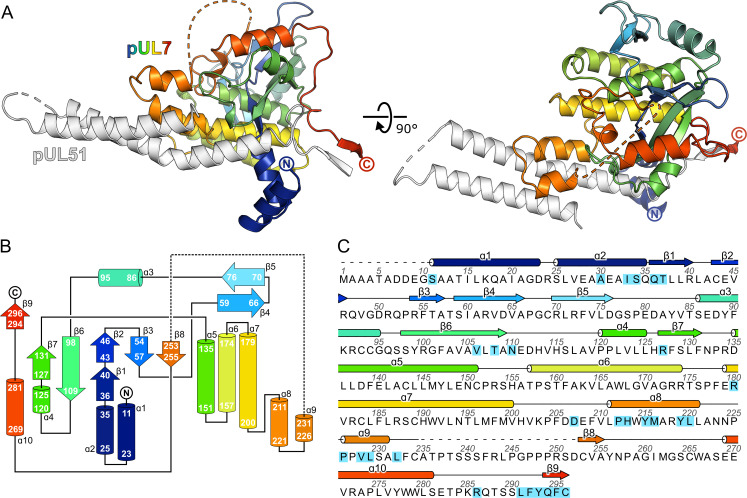
The CUSTARD fold of pUL7.(A) Structure of pUL7:pUL51(8–142) core heterodimer is shown as ribbons, with pUL51 colored white and pUL7 colored from blue (residue 11) to red (residue 296). Two orthogonal views are shown. (B) Schematic diagram of the topology of pUL7. (C) HSV-1 pUL7 sequence, with secondary structure shown above. Residues that interact with pUL51 are highlighted in cyan.